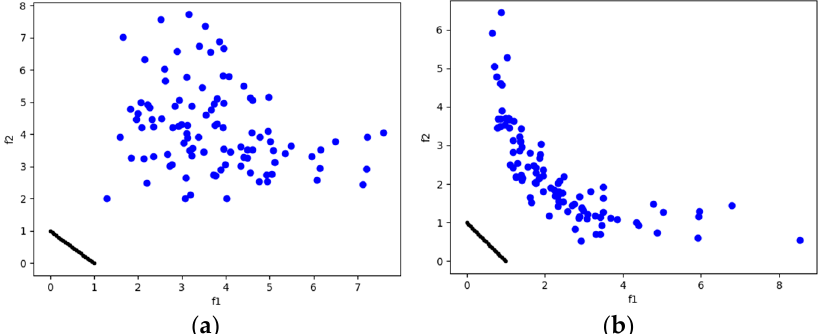
Figure 13. The plots of the approximate PFs with the highest HV value against real PF. ( a ) UF5 approximate PF using MOSA/D-CGO; ( b ) UF5 approximate PF using MOSA/D-DE.